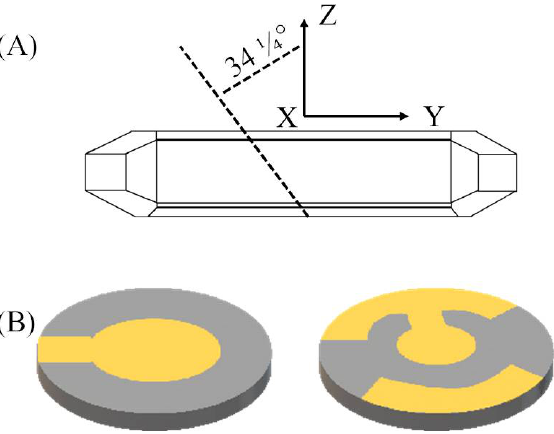
Figure 3. ( A ) AT-cut crystal scheme, and ( B ) QCR with gold electrodes scheme. Depending on the thickness between the nodes and the antinodes of the crystal, the wave formed when a voltage is applied will have a specific wavelength. This relationship is given by the following Equation